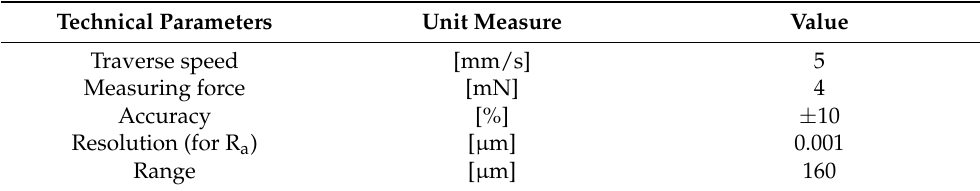
Table 3. Technical parameters of equipment ISR-100 used for surface roughness analysis.